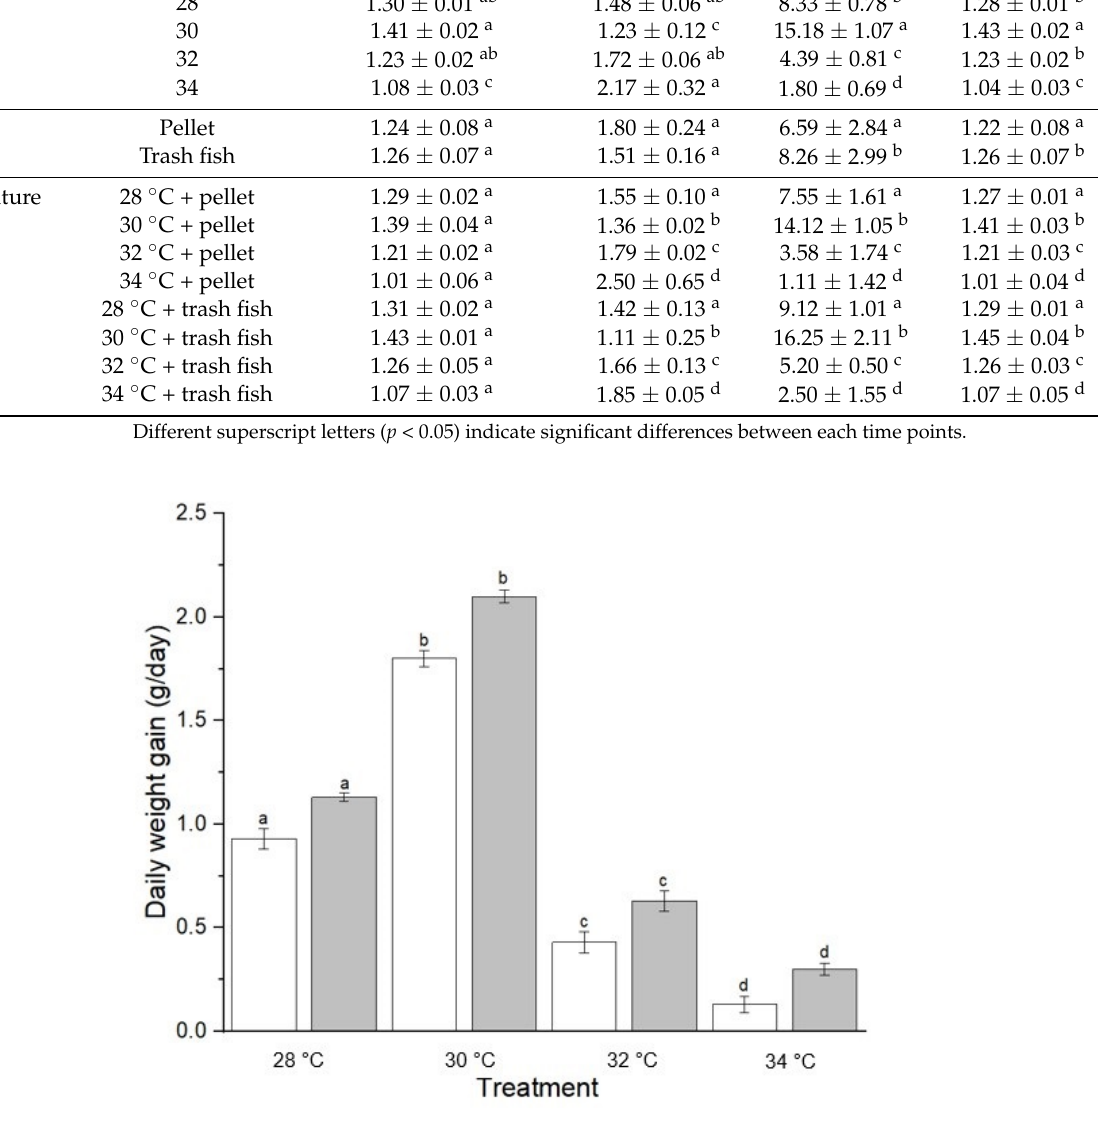
Figure 8. Daily weight gain of hybrid Sabah grouper in treatments at different temperatures and fed for 30 days. White bar represented pellet while gray bar represented trash fish. Different letters indicated significant differences among treatments ( p < 0.05).